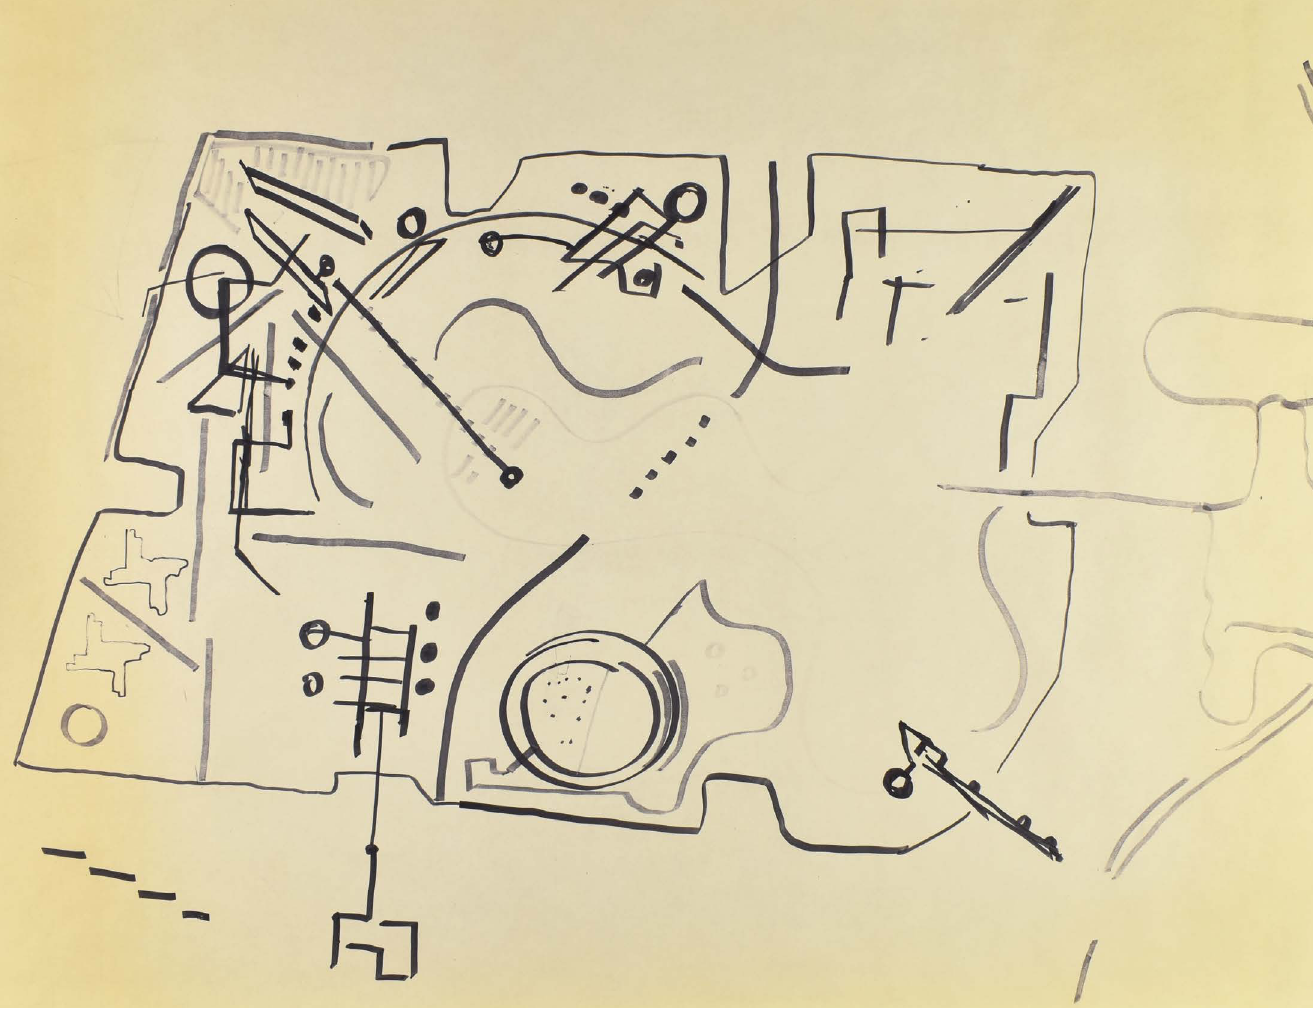
Novoli plan designed by Leon- ardo Ricci [1988].